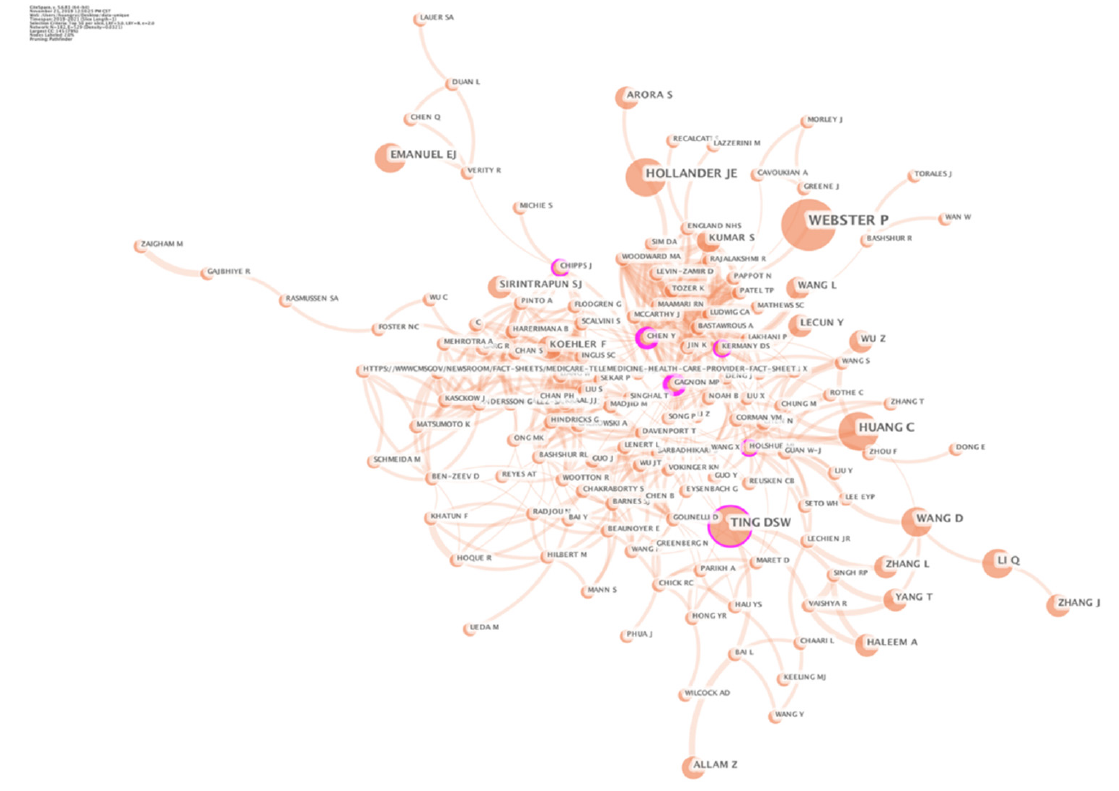
Figure 4. The cooperation network of cited author.